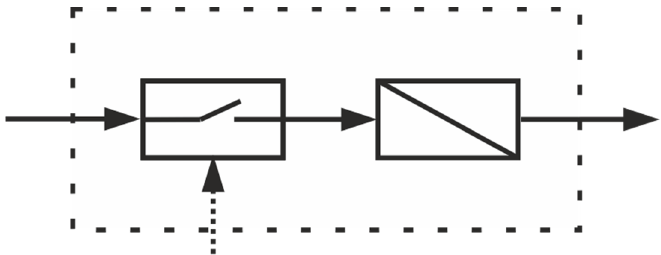
Figure 4. The minimal function structure of an actuation system according to [27,28]. Each actuator is made up of at least one switch and an energy converter [27,28]. This